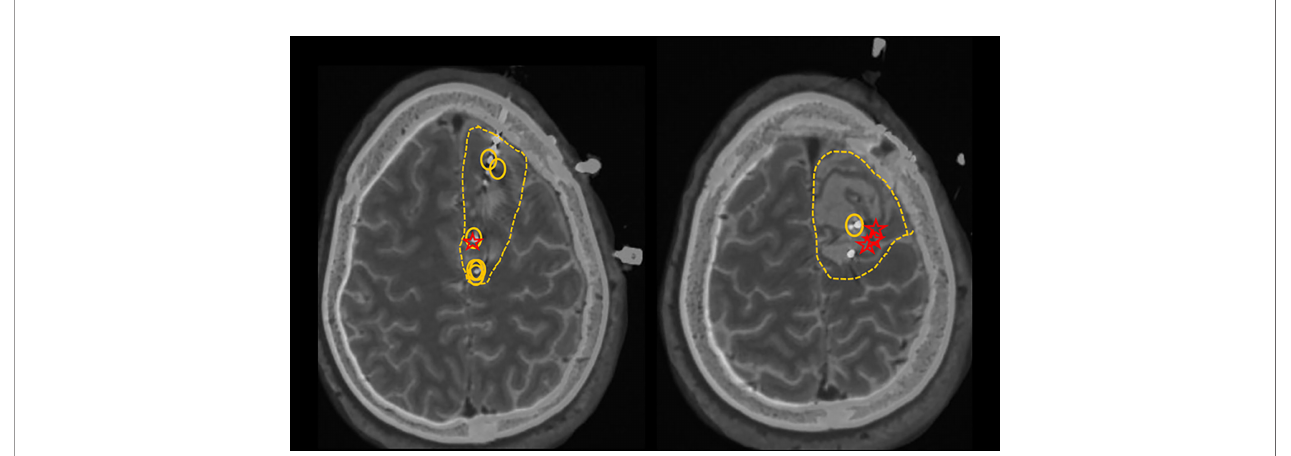
FIGURE 1 | Circles represent active interictal epileptiform discharges (the irritative zones). Stars represent the fi rst involved contacts at the ictal onset. Dashed lines represent the proposed resection